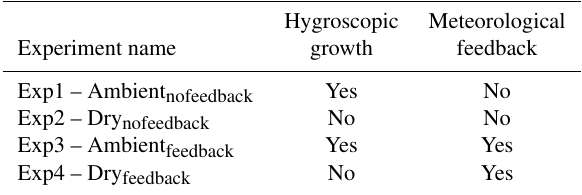
Table 1. Experimental